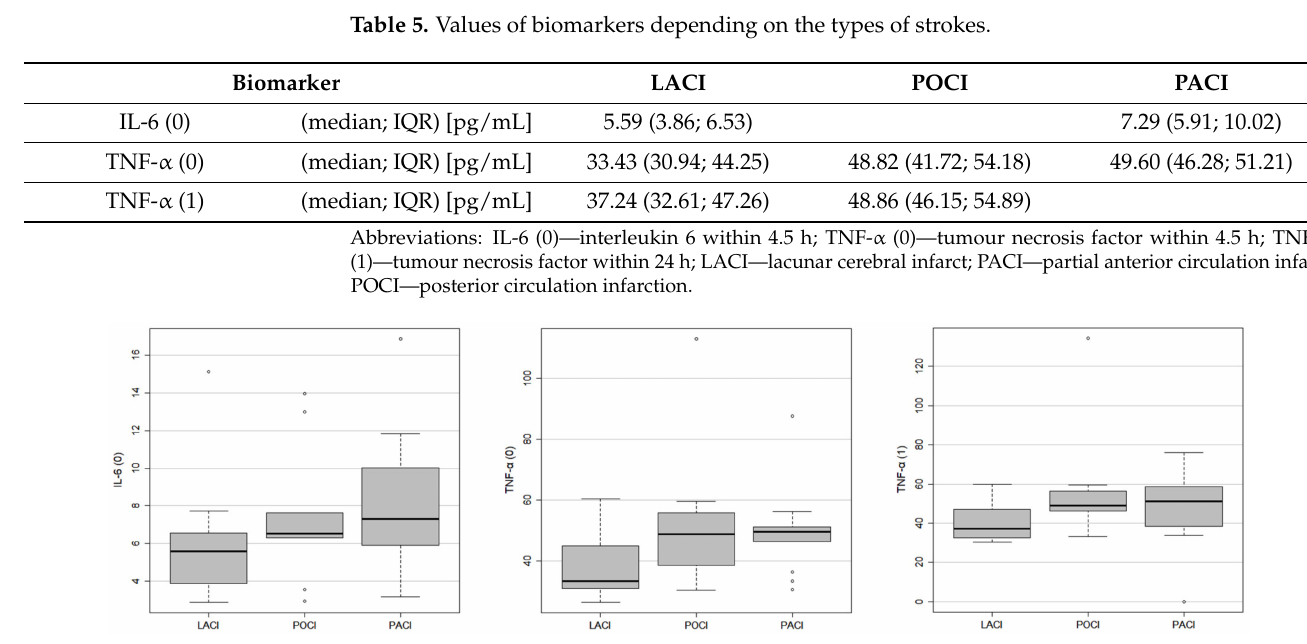
Figure 4. Inflammatory biomarkers by subtypes of stroke. Abbreviations: IL-6 (0)—interleukin 6 within 4.5 h; TNF- α (0)—tumour necrosis factor within 4.5 h; TNF- α (1)—tumour necrosis fac- tor within 24 h; LACI—lacunar cerebral infarct; PACI—partial anterior circulation infarct; POCI— posterior circulation infarction.